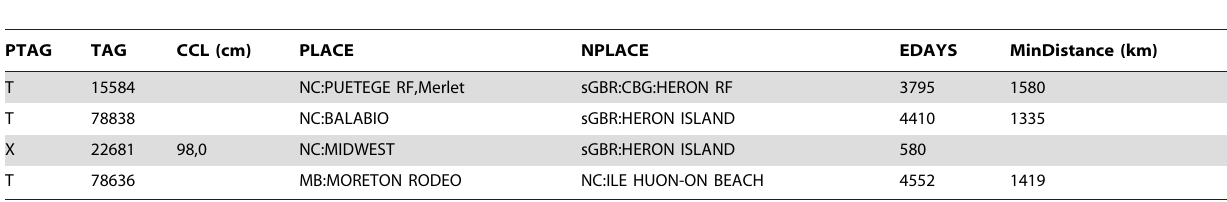
Table 2. Case histories illustrating male C. mydas migration across the Coral Sea.